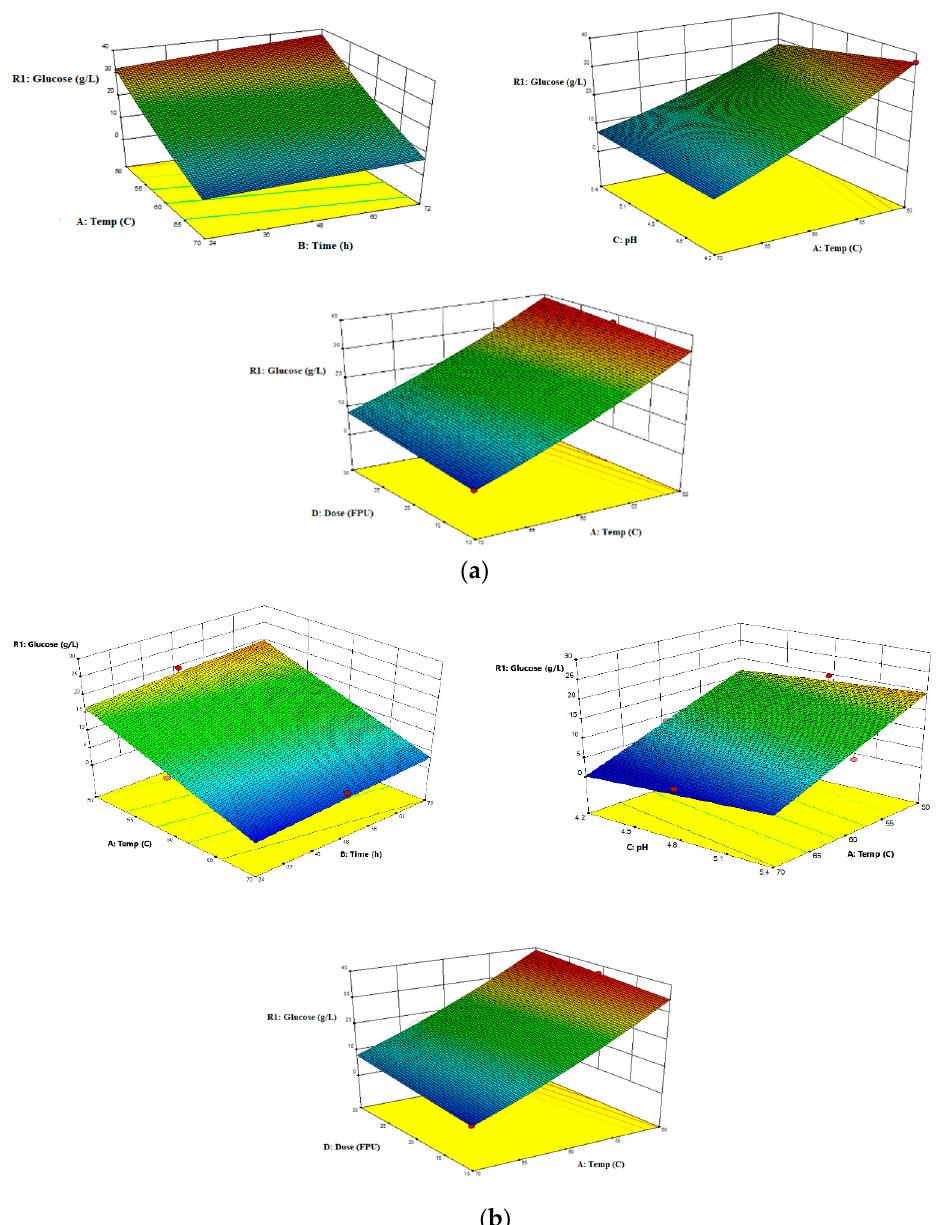
Figure 3. Enzymatic hydrolysis process of hemp biomass (RSM). Response surface representing the interaction effects of temperature, time, dose, and pH on glucose yield: ( a ) Tygra biomass, ( b ) Rajan biomass.